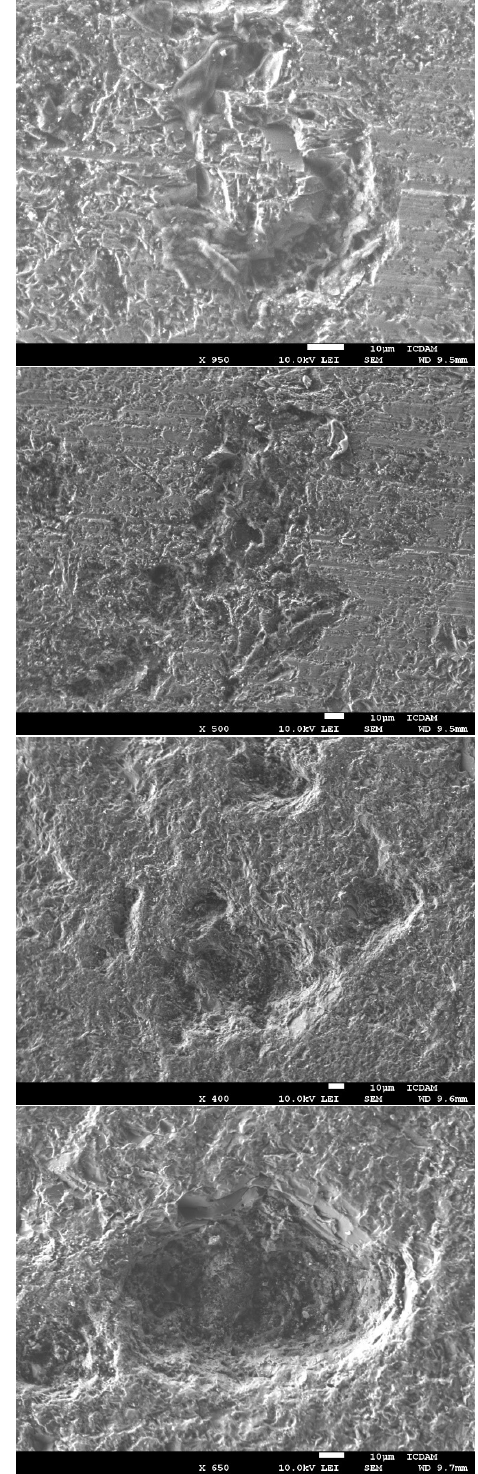
Figure 5. Surface defects of SiC cutting ceramic after grinding by diamond disc (5a, 5b) and AAT (5c,